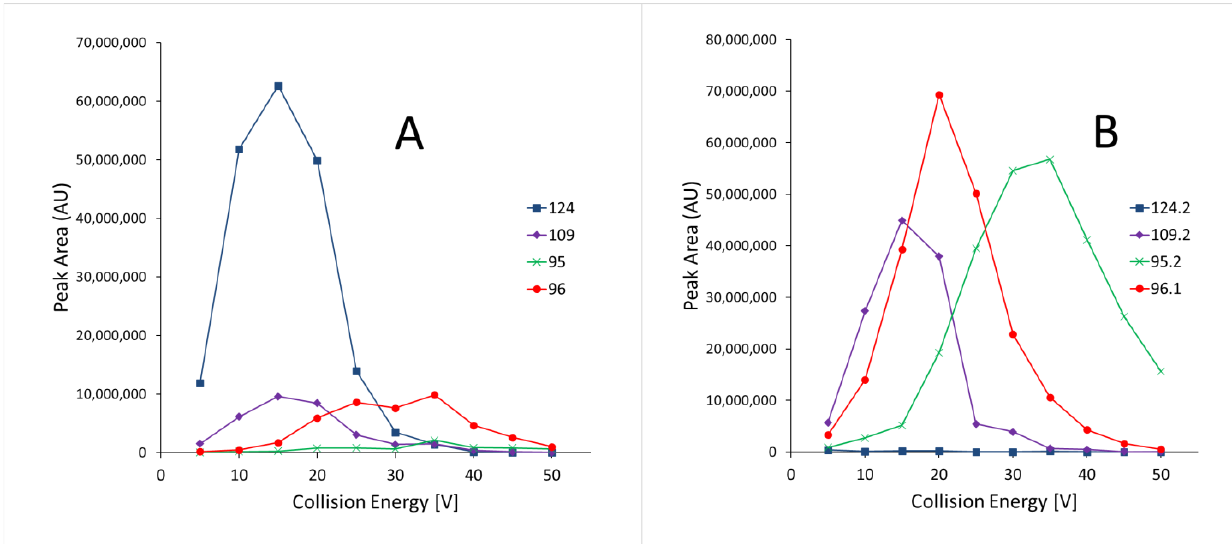
Figure 1. Ion breakdown curves in absolute intensities of the most selective and intense fragment ions for ( A ) τ -MH and ( B ) π -MH. Each value corresponds to an average of 50 scans. It is demonstrated that the most intense ion fragments are 124 in the case of τ -MH and 96 and 95 in the case of π -MH. The intensity of ion 124 is significantly higher in the mass spectrum of τ -MH, while that of ion 95 is significantly higher in the mass spectrum of π -MH. Fragment ions 109 and 96 are present in significant intensities in both isomer breakdown curves.